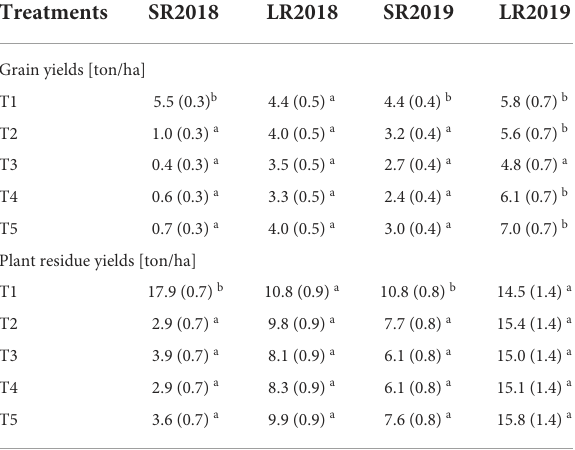
TABLE 6 Comparison of grain and residue yields between treatments over 4 crop-growing seasons during 2018 and 2019. Treatments